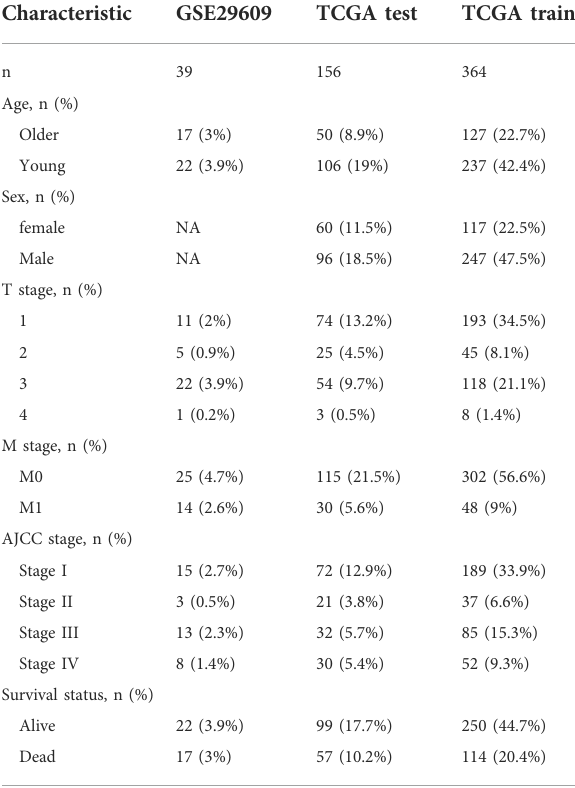
TABLE 1 Clinicopathologic characteristics of the included patients.